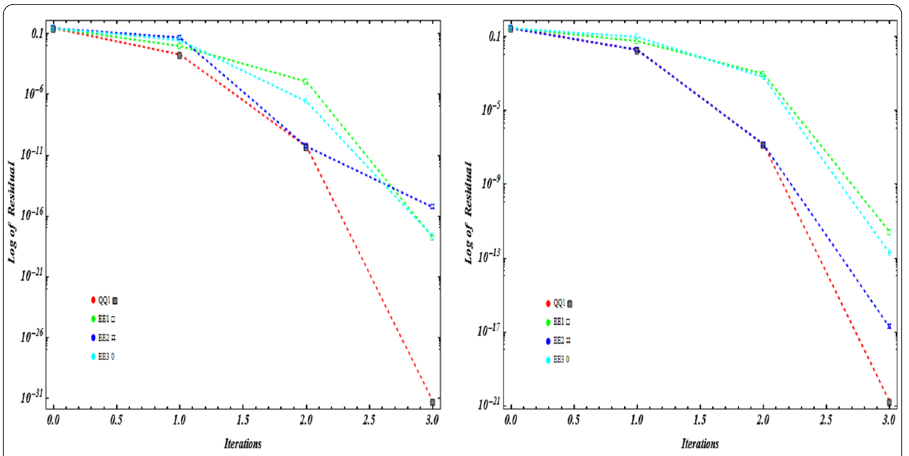
Table 6 Comparison of optimal 3rd order methods F 5 F 6 F 5 F 6 F 5 F 6 Number of iterations Method m = 50 m = 75 m = 100 QQ1 4 4